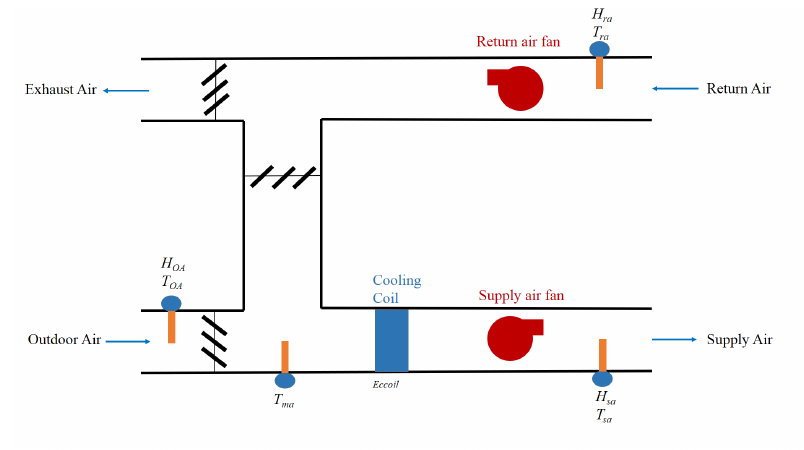
Figure 1. The general structure of the Air handling unit (AHU) used in ASHRAE project No. RP-1312 with critical features marked.